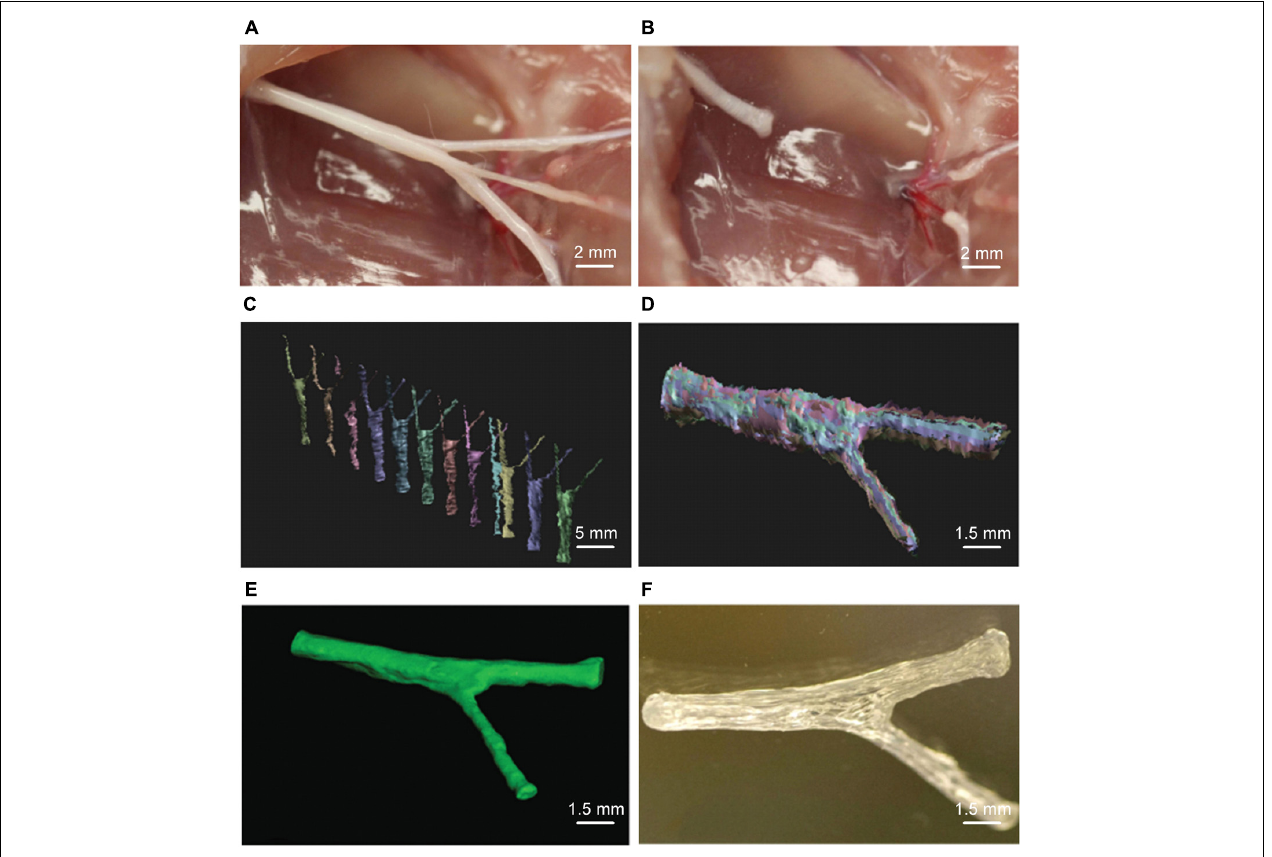
FIGURE 1 | Microextrusion printing rat complex structure sciatic nerve conduit. (A) Photographs of sciatic nerve including both of sensory and motor nerve branches and (B) corresponding sciatic nerve defect. (C) Scans for 3D reconstruction from various perspectives by structured light scanning system. (D) The process of three-dimensional reconstruction of data. (E) Image after 3D reconstruction of the scan data of the sciatic nerve. (F) Image of the microextrusion printed sciatic nerve conduit. Reproduced with permission from Johnson et al.